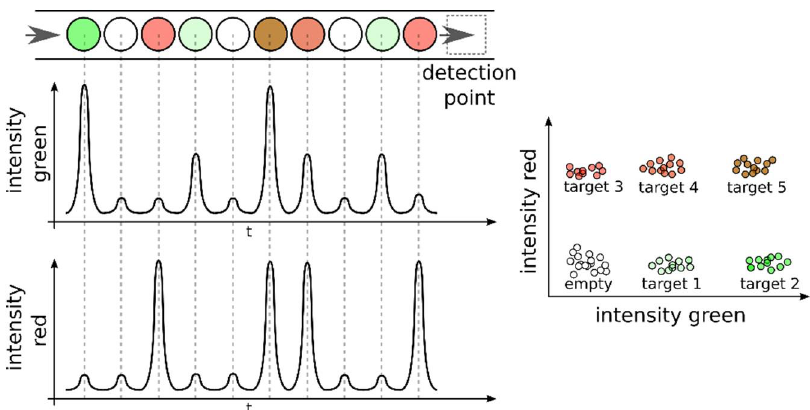
Figure 10. Multiplex droplet dPCR assays. dPCR assays can be multiplexed by coding the level of fluorescence of the plateau phase because dPCR can be implemented as a non-competing template assay, where each target is isolated in different partitions.